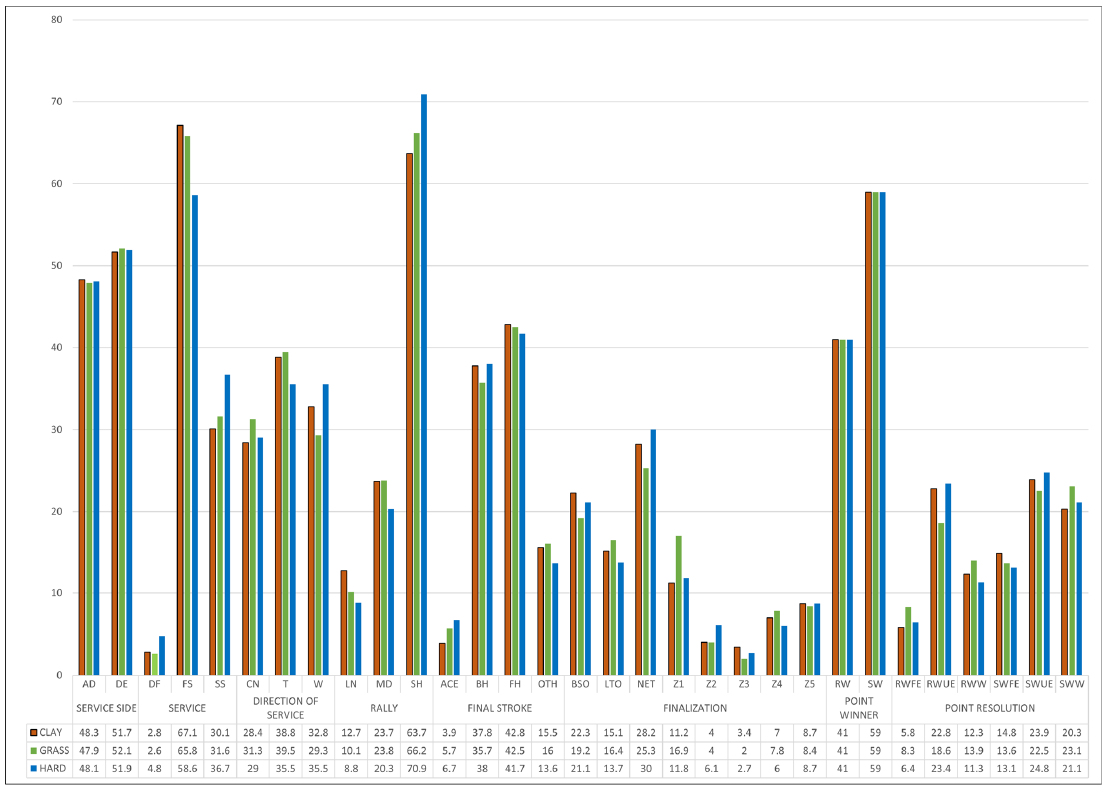
Figure 2. Distribution of the points played on the different surfaces in the 2019 season. Except in the criteria side of service, statistically significant differences ( p ≤ 0.05)